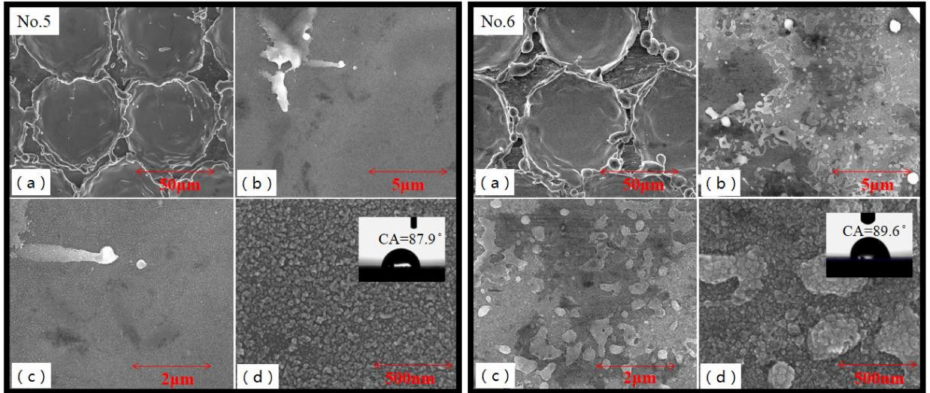
Figure 7. SEM images of No.5 and No.6 samples treated by large laser spot spacing. Reference bars on these figures from ( a – d ) were 50 µ m, 5 µ m, 2 µ m, and 500 nm,